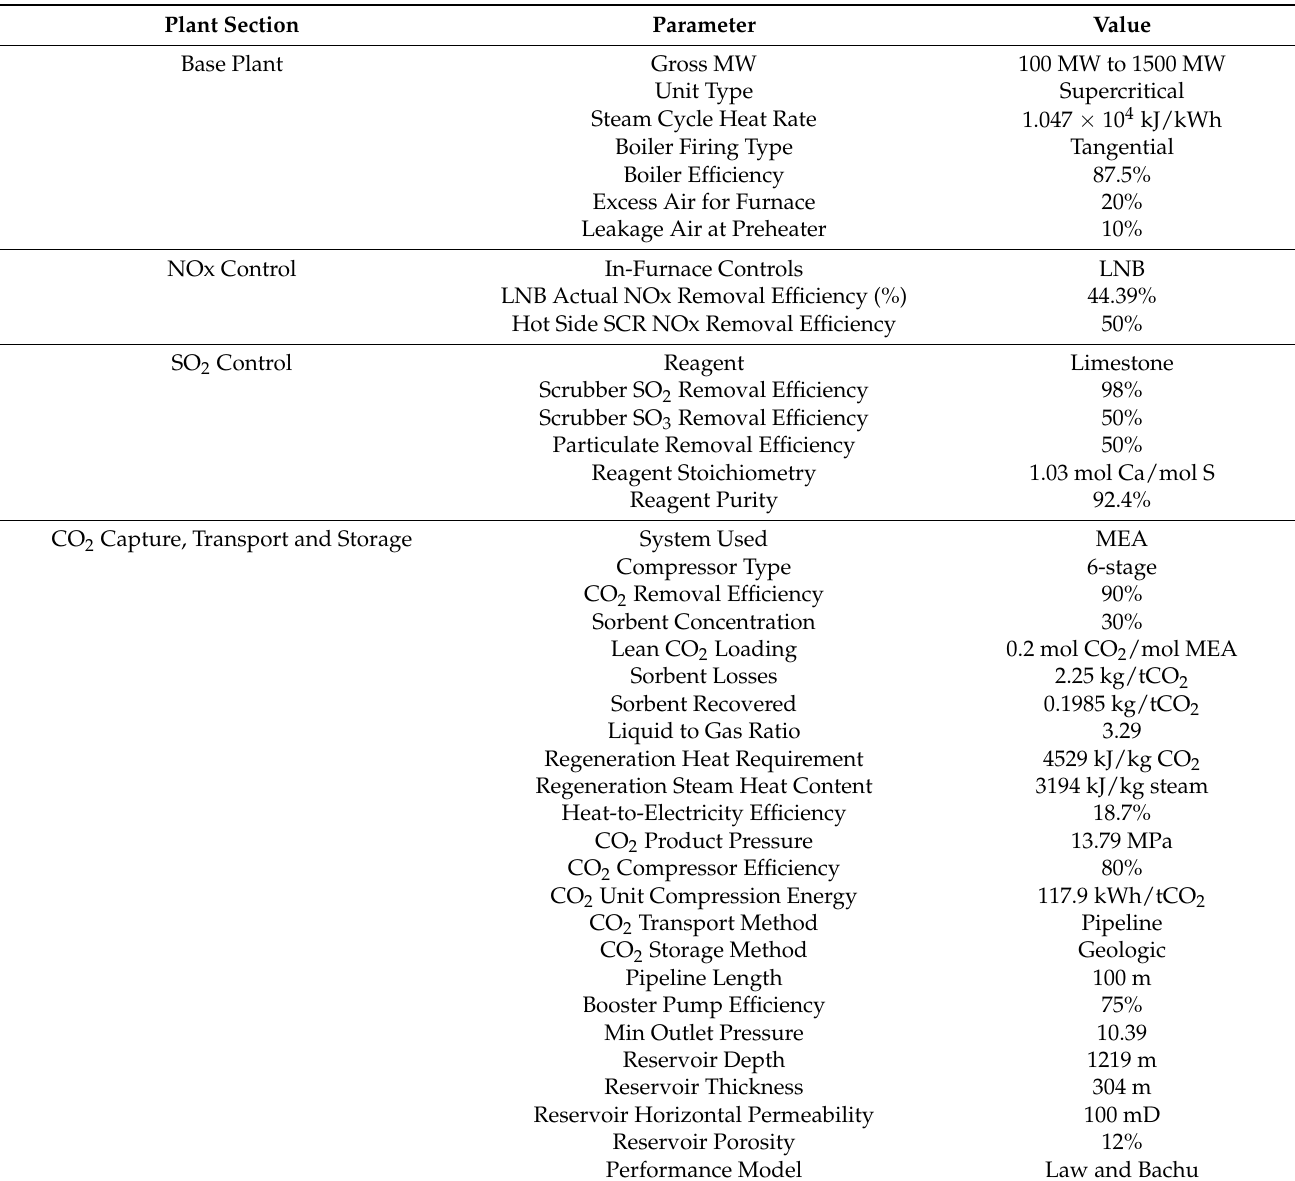
Table A10. Modeling parameters used for pulverized combustion (PC) powerplants in the IECM.